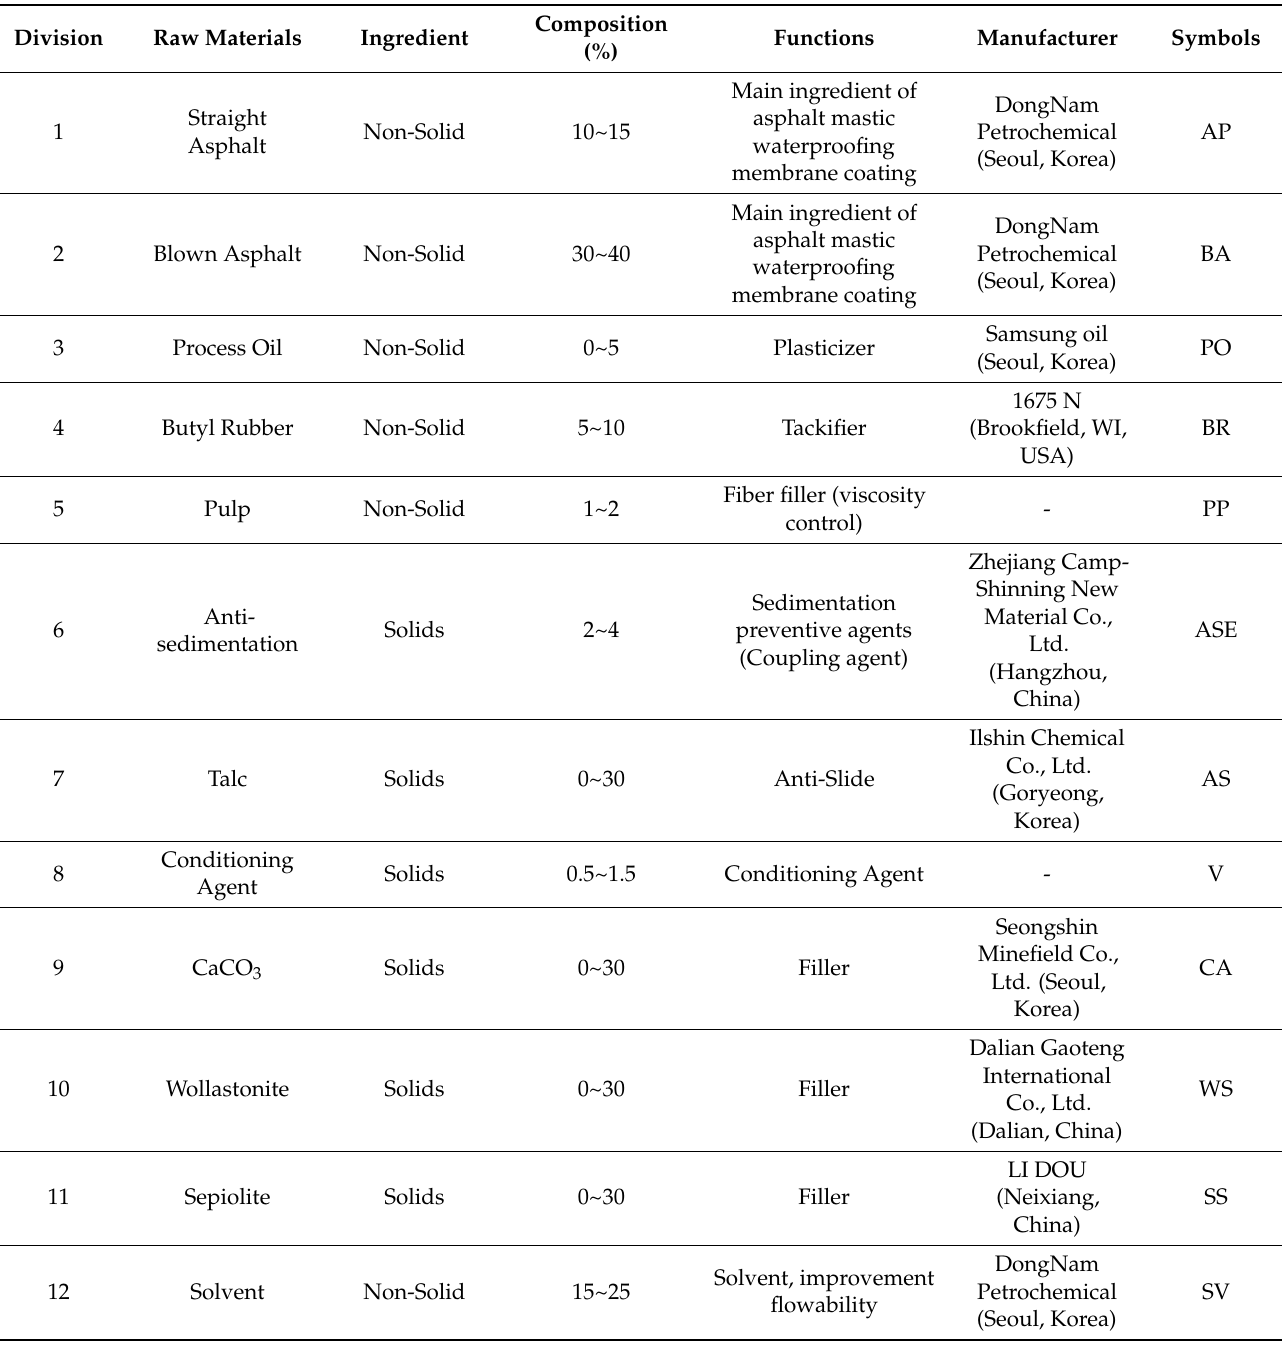
Table 2. Material composition of asphalt